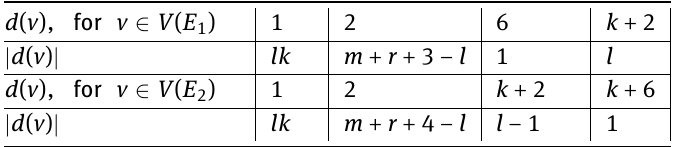
Table 5: Vertex-partitions of the tricyclic graphs E 1 and E 2